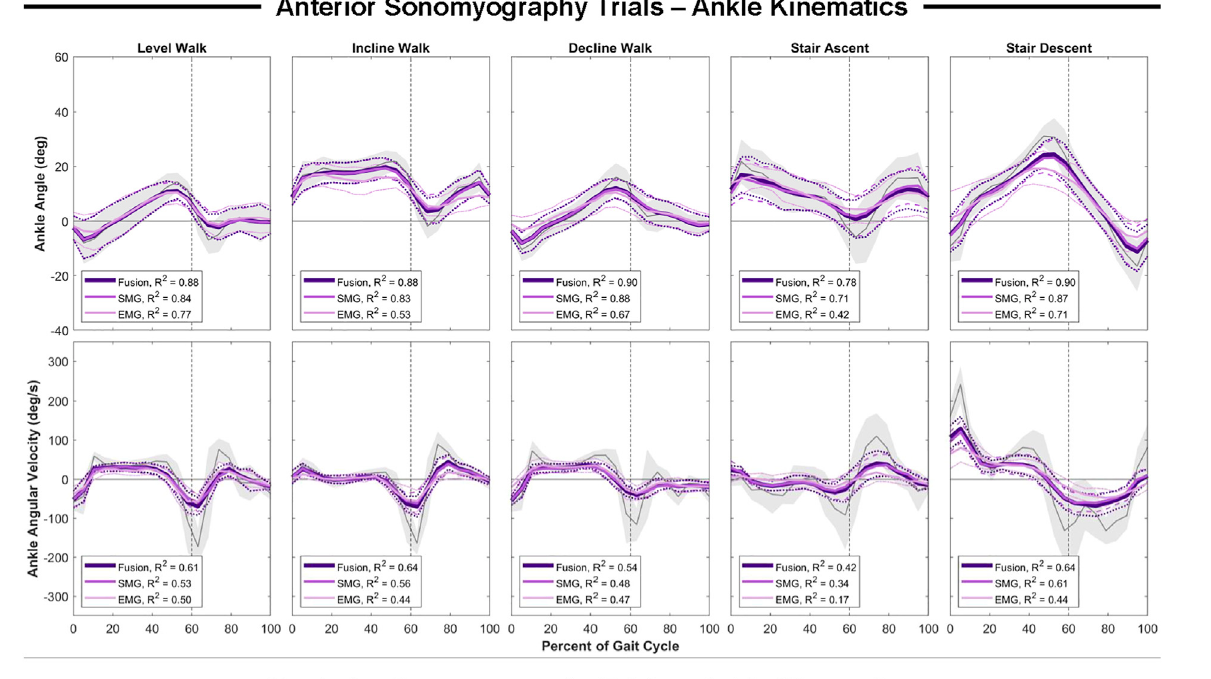
Frontiers in Robotics and AI |